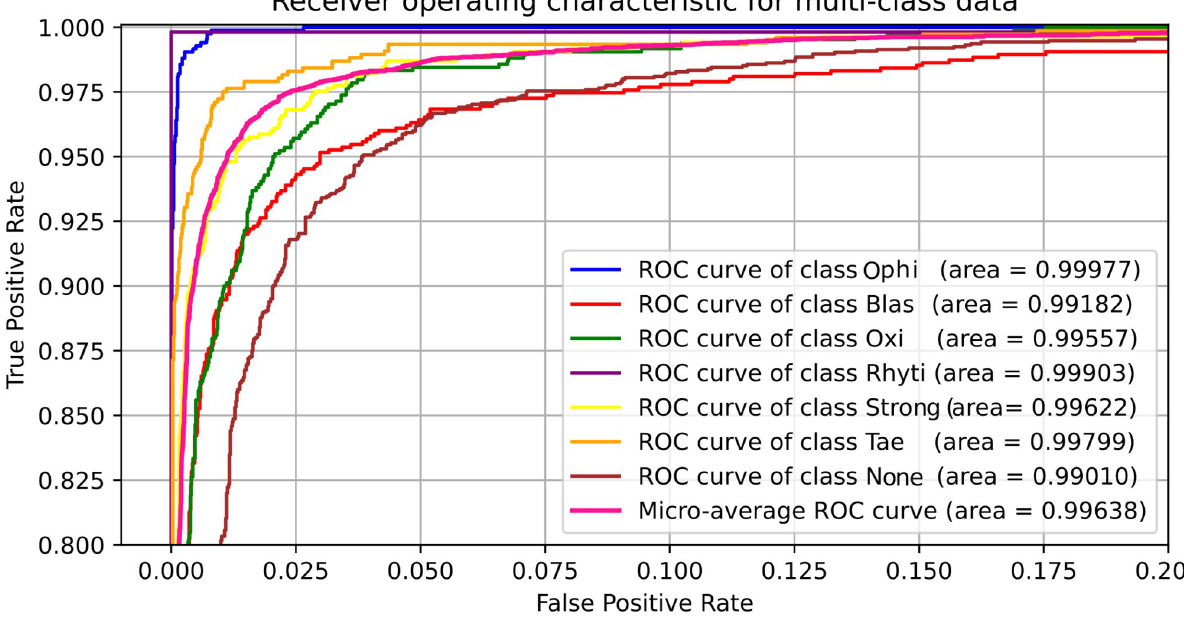
PLOS ONE | https://doi.org/10.1371/journal.pone.0271529 August 4, 2022 16 /